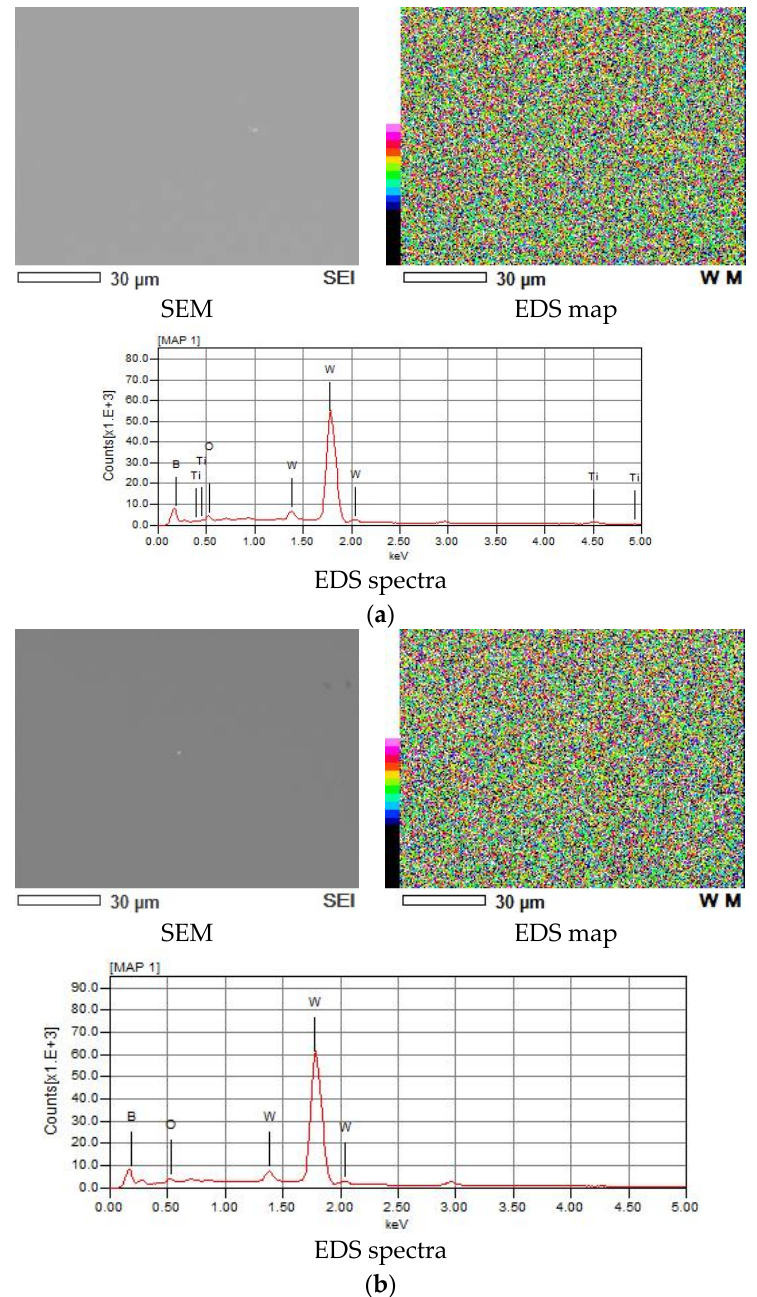
Figure 3. Chemical composition of ( a ) W-Ti-B and ( b ) W-B film based on SEM + EDS analysis of deposited coatings. The colored map presents distribution of tungsten.